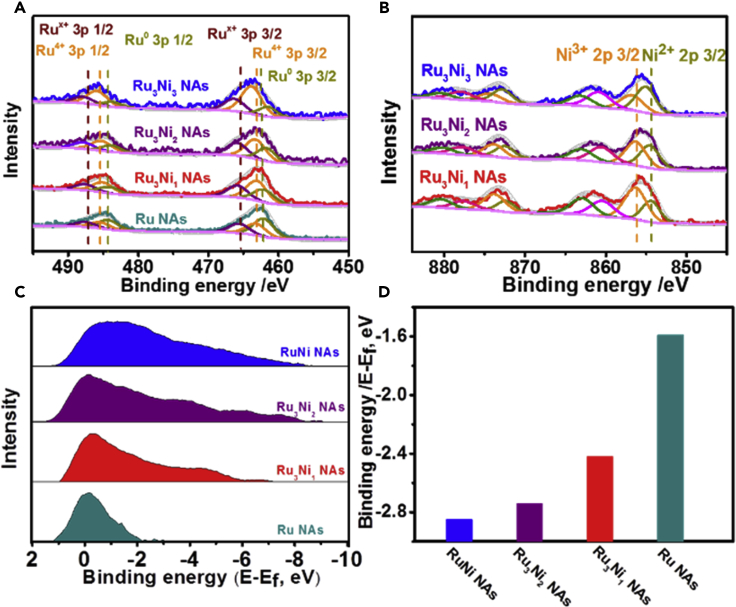
XPS Analysis of the Ru3Ni3 NAs, Ru3Ni2 NAs, Ru3Ni1 NAs, and Ru NAs(A and B) (A) Ru 3p and (B) Ni 2p curves of the Ru3Ni3 NAs, Ru3Ni2 NAs, Ru3Ni1 NAs, and Ru NAs heated at 350°C in air for 2 h.(C and D) (C) Surface valence band photoemission spectra and (D) corresponding d-band centers of the Ru3Ni3 NAs, Ru3Ni2 NAs, Ru3Ni1 NAs, and Ru NAs heated at 250°C in air for 1 h.